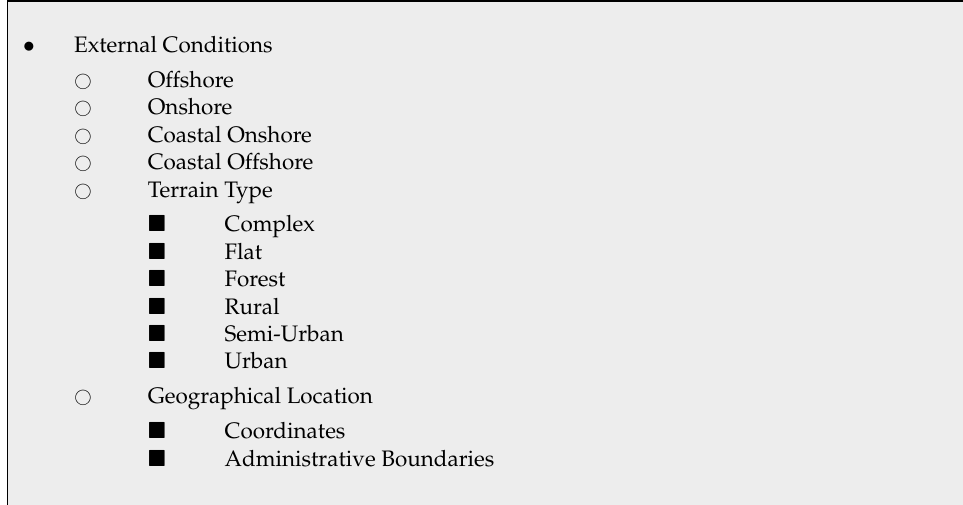
Table 23. Hierarchy for External condition-related